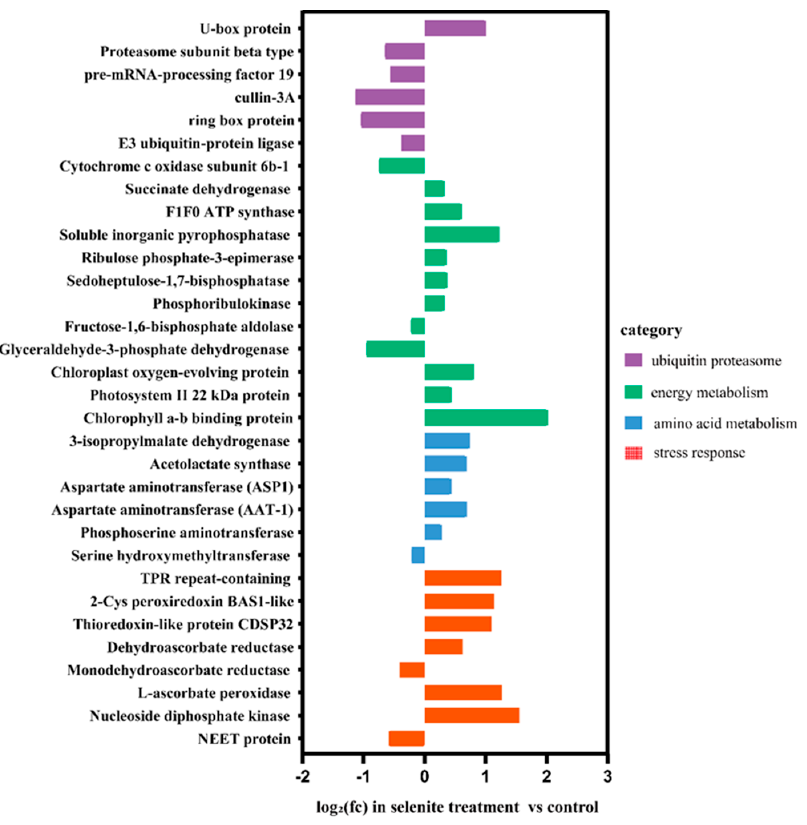
Figure 6. Changes in the protein abundance of D. salina under the selenite treatments. Negative values indicate downregulation and positive values indicate upregulation of the proteins.